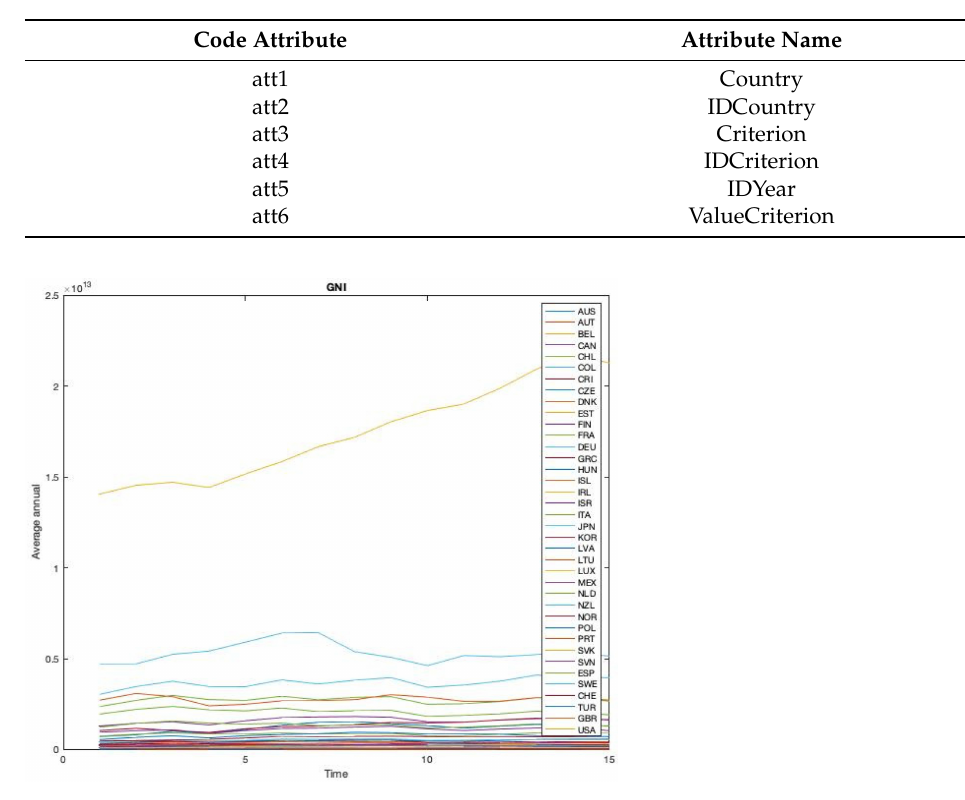
Table 3. GNI: attributes of the time series.